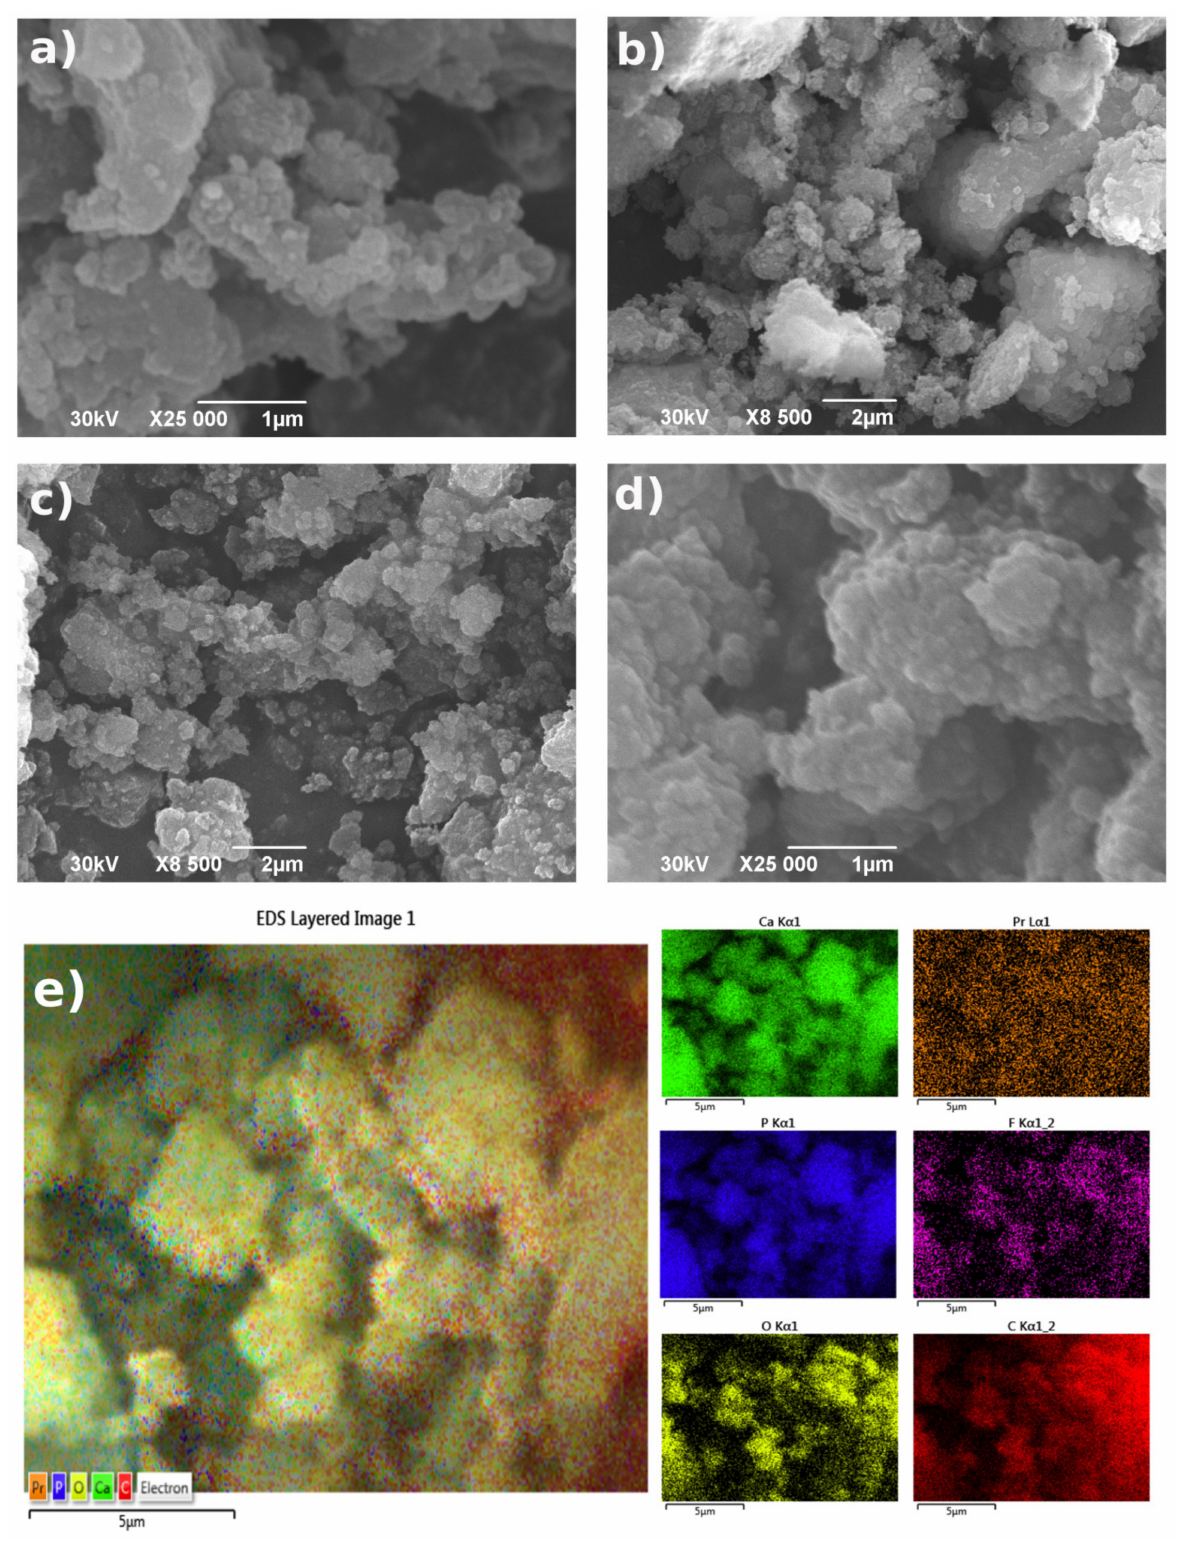
Figure 4. Scanning electron micrographs of FAP ( a ), Pr0.1CFAP ( b ), Pr0.5CFAP ( c ) and Pr1CFAP ( d ) samples. EDS mapping distribution of elements in the Pr1CFAP sample ( e